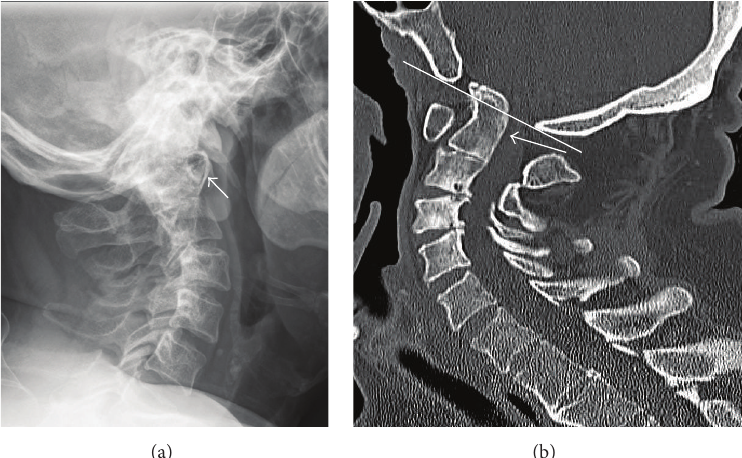
Figure 3: Lateral radiograph of patient with severe cranial settling. Of note, the settling is so severe that the dens is not identifiable due to overlying mastoid air cells and skull base, arrow identifying the anterior arch of C1 (a). Sagittal reconstructions of computed tomography of the cervical spine in the same patient. Note the anterior arch of C1 is at Station III and the dens ( arrow ) projects through the inferior margin ( line ) of the foramen magnum